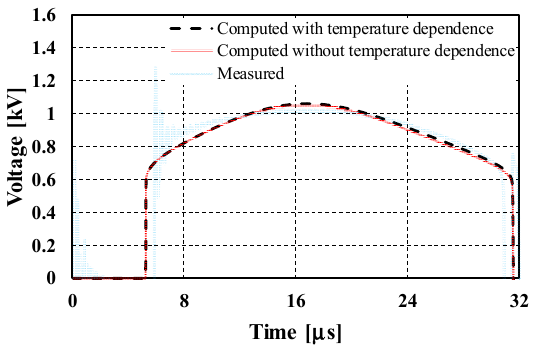
Figure 6. Measured and FDTD-calculated waveforms of voltage generated across the MOV element: Response to the impulse current shown in Figure